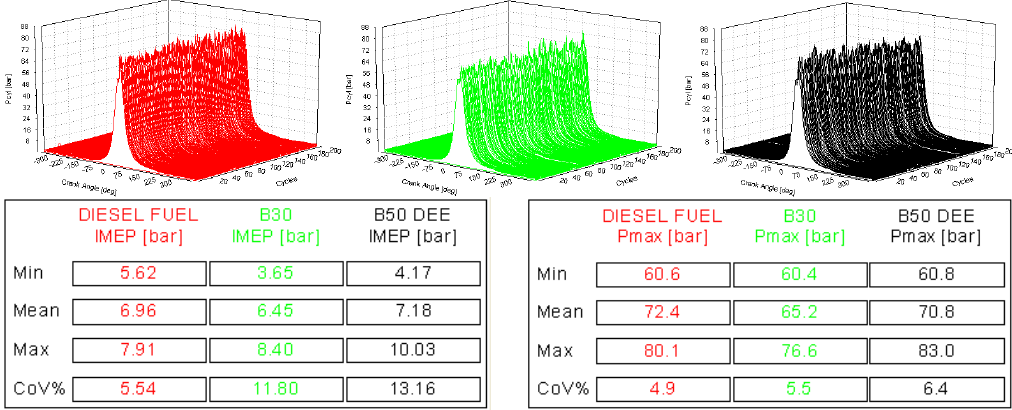
Figure 11. Cycle ‐ to ‐ cycle analysis during the idling stage.